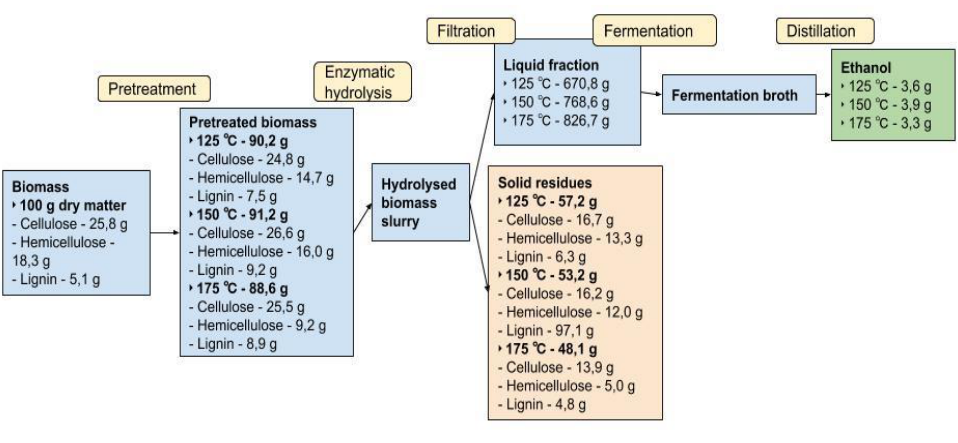
Fig. 4. Mass balance of bioethanol production process when different pretreatment temperatures were used and solid and liquid parts of hydrolysis slurry were separated after hydrolysis and only liquid fraction was used for fermentation.